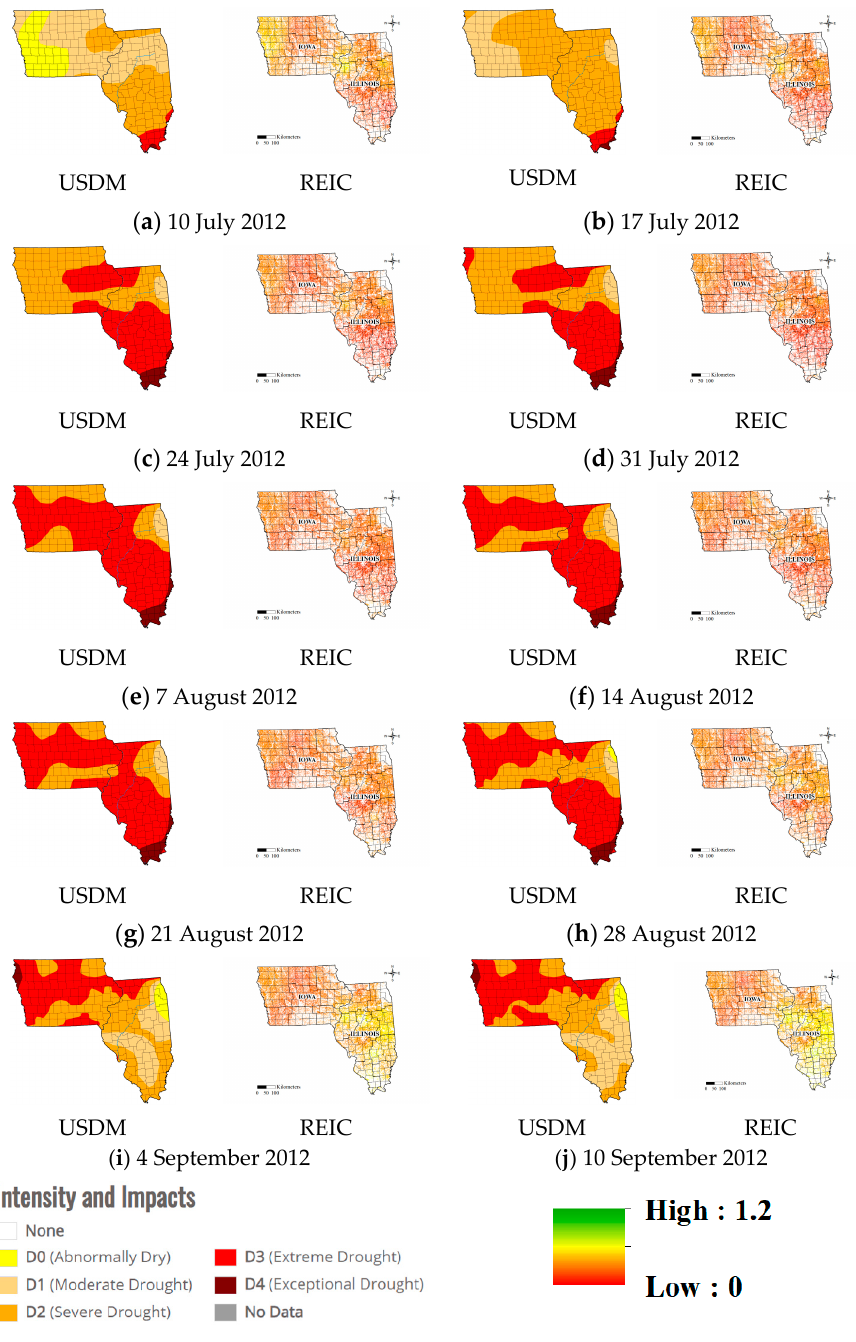
Figure 9. Comparison of USDM data and accumulated REIC.